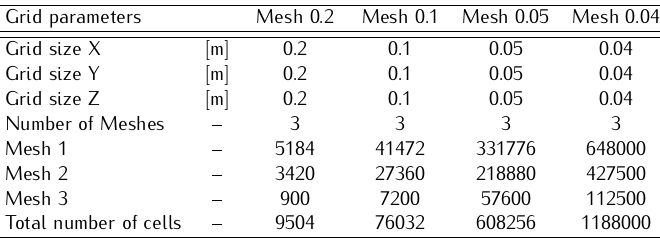
Table 2. Grid independent study – meshes parameters.